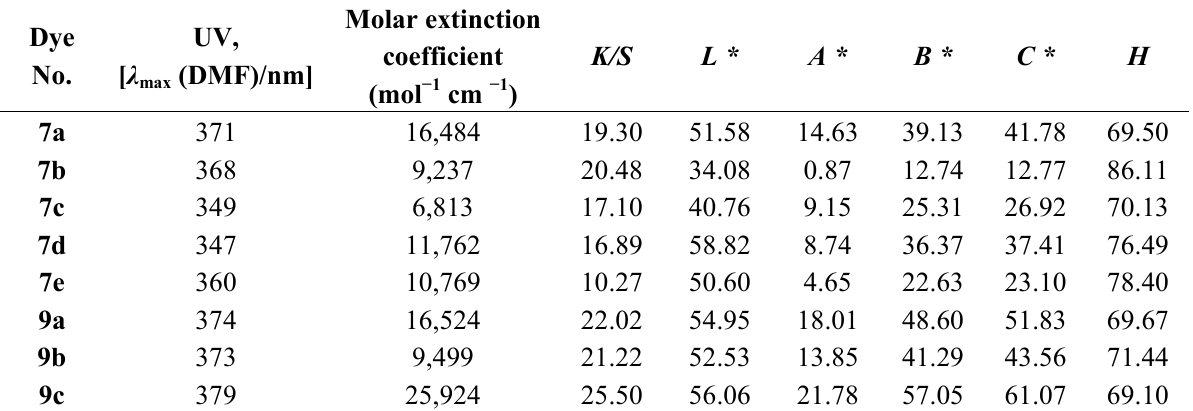
Table 1. Optical measurements of the synthesized monoazo compounds on the polyester fabrics. Dye